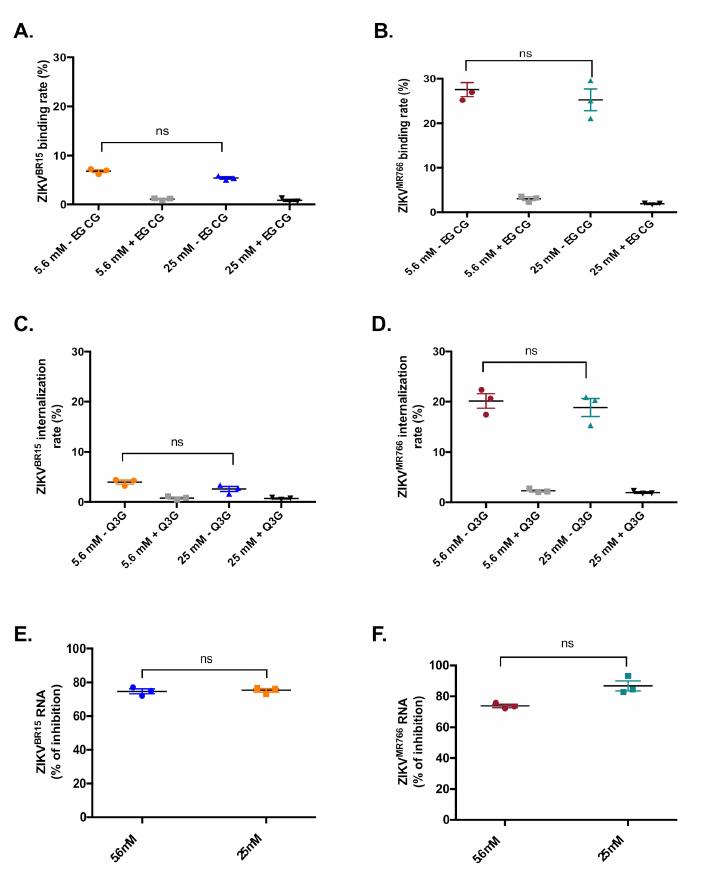
Figure 3. High glucose level does not affect ZIKV entry in HK-2 cells. For virus binding assay ( A , B ), HK-2 cells were infected for 1 h at 4 ◦ C with ZIKV BR15 and ZIKV MR766 , respectively, at MOI of 1. The epigallocatechin gallate (EGCG) described to inhibit the ZIKV attachment step was used as a positive control at 100 µ M. The amount of viral particles attached to the cell surface was quantified by RT-qPCR. For the virus internalization assay, HK-2 cells were incubated 1 h with ZIKV BR15 ( C ) and ZIKV MR766 ( D ) at 4 ◦ C and then shifted to 37 ◦ C for 1 h. Isoquercitrin (Q3G) known to inhibit the ZIKV internalization step was used as a positive control at 200 µ M. The amount of viral particles internalized into HK-2 cells was determined by RT-qPCR. For virus fusion assay, HK-2 cells were incubated with ZIKV BR15 ( E ) and ZIKV MR766 ( F ) at MOI of 1 at 4 ◦ C then shifted to 37 ◦ C for 1 h. Chloroquine was added for 2 h at 37 ◦ C. Viral genomic RNA was measured by RT-qPCR. Results are expressed as the percentage of viral fusion inhibition by chloroquine under both glucose conditions. Results are shown as means ± SEM of three independent experiments. Mann–Whitney test was used for statistical analysis (n.s. = not